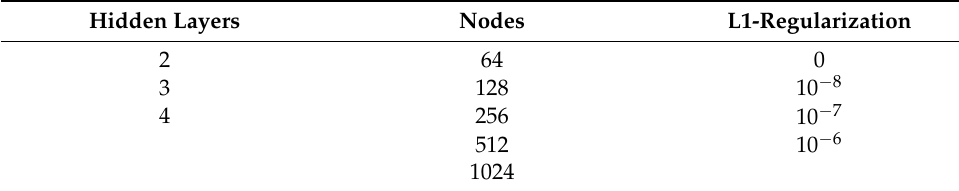
Table 1. Set of hyperparameters for the grid search method. Hidden Layers Nodes